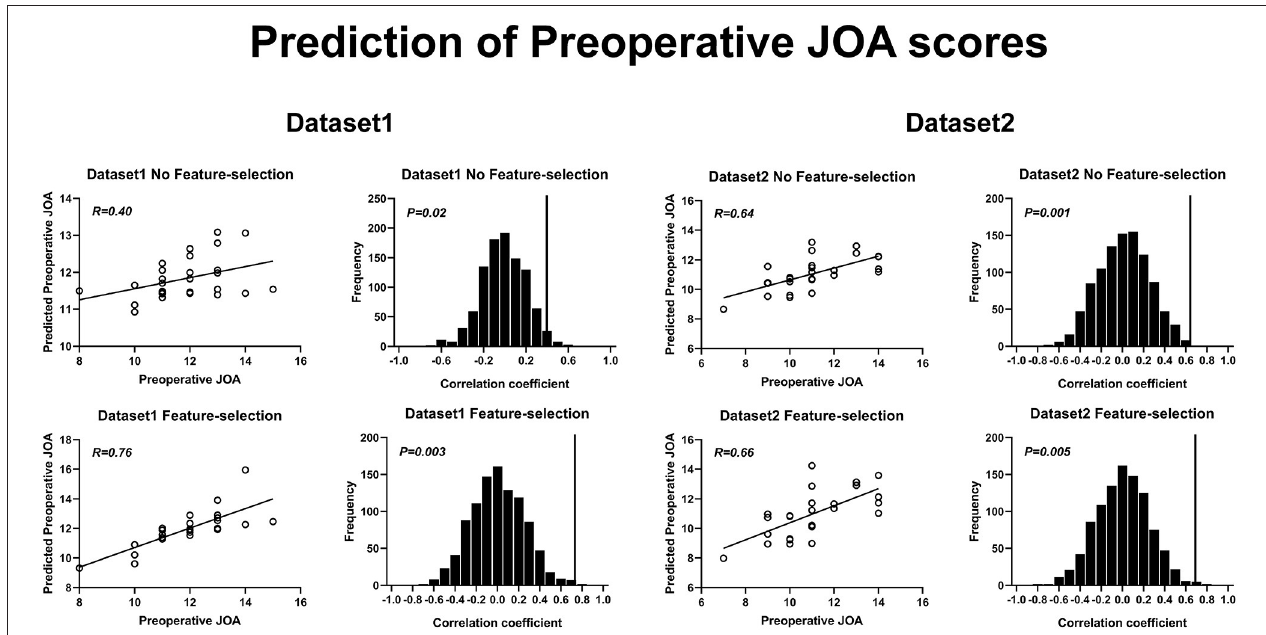
Pre-JOA JOA recovery JOA recovery rate Feature No feature Feature selection selection selection